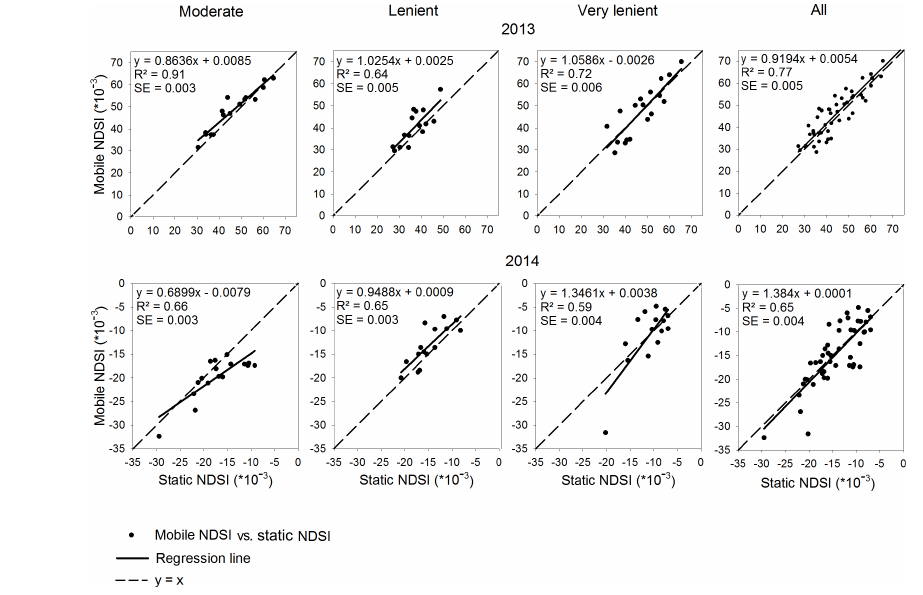
Figure 4. Relationship between mobile- and statically measured normalized difference spectral index (NDSI). Both measurements were conducted on reference plots in pastures differently stocked with animals in 2013 and 2014. Table 2. Regression and cross-validation statistics of prediction models for biomass ( B ) (g FMm − 2 ) from USH (cm) and narrowband NDSI during mobile application. Models were derived from static measurements on reference plots according Eqs. (1) and (2) (see above) ( n =